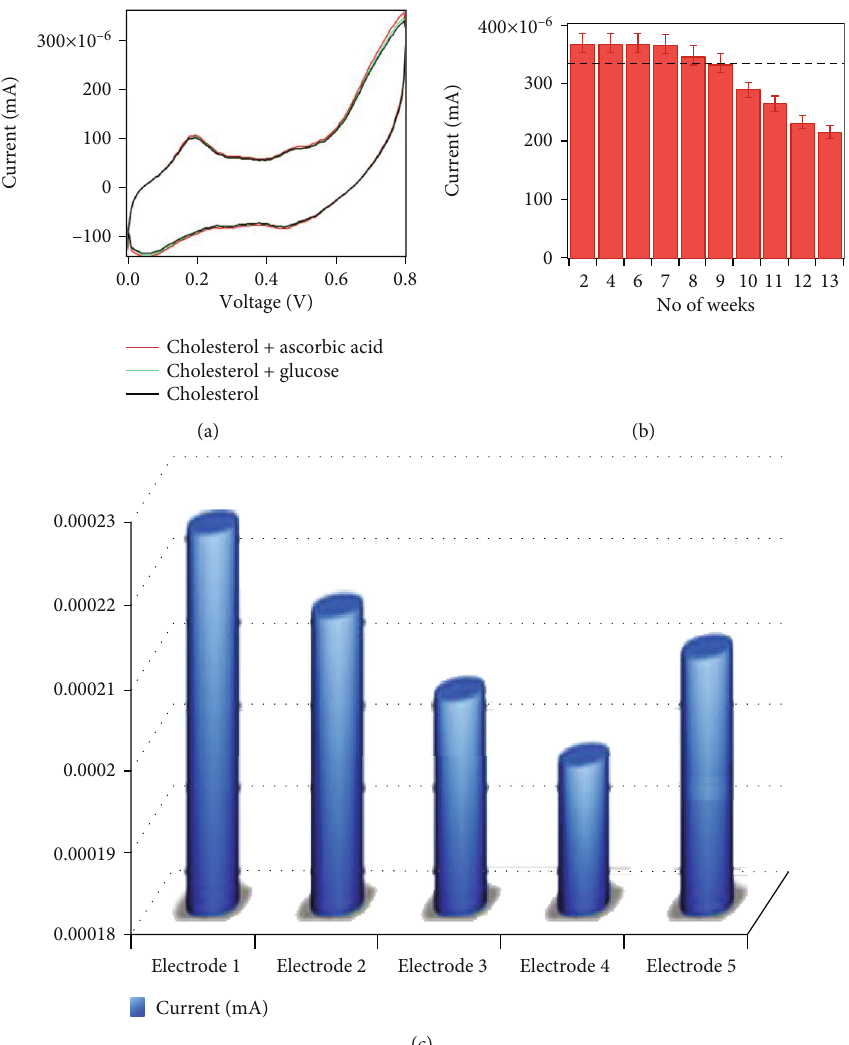
Figure 8: Results of (a) selectivity and (b) storage stability and (c) reproducibility of ChOx/CeO scan rates in the presence of 200mg/dL cholesterol